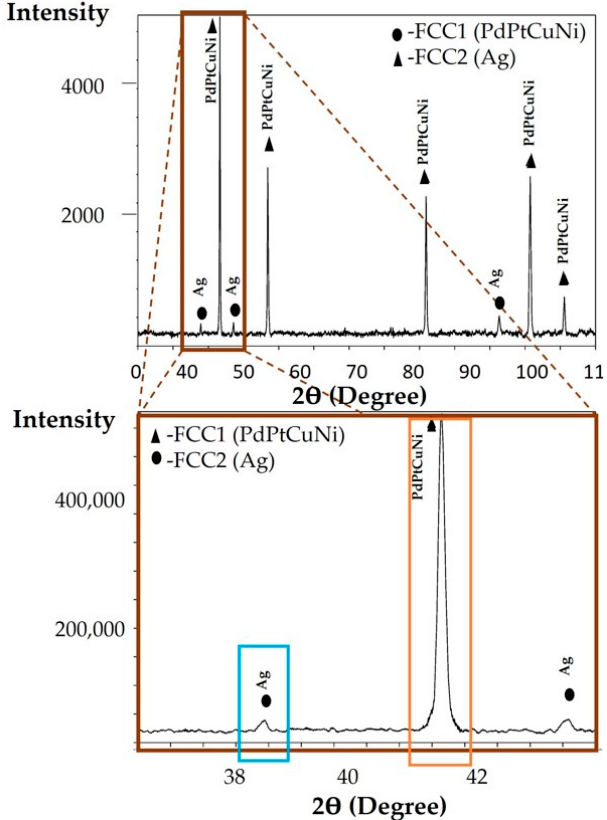
Figure 7. XRD analysis of an annealed CCNA sample and XRD analysis in the range 37–44 θ